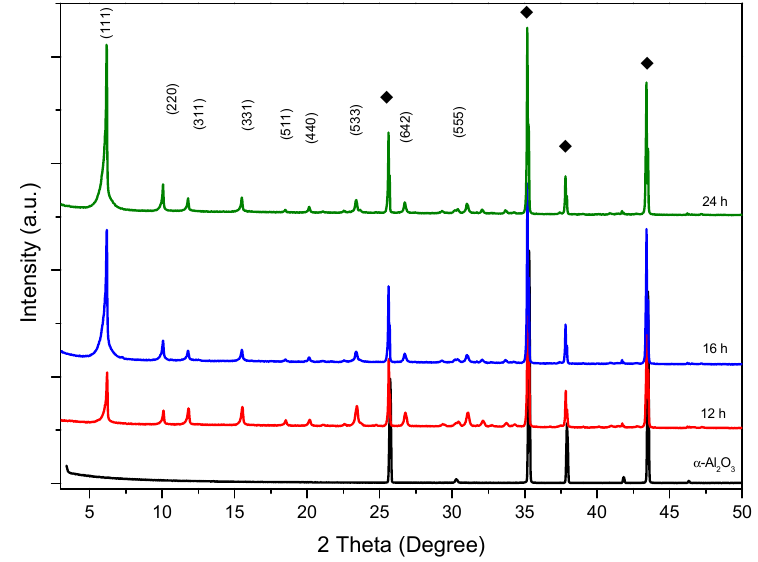
Figure 1. X-ray diffraction (XRD) patterns of FAU-type zeolite membranes prepared on Alconox ® - treated α -Al 2 O 3 supports at 75 °C for 12, 16, and 24 h. (Black diamonds indicate the peaks of α -Al 2 O 3